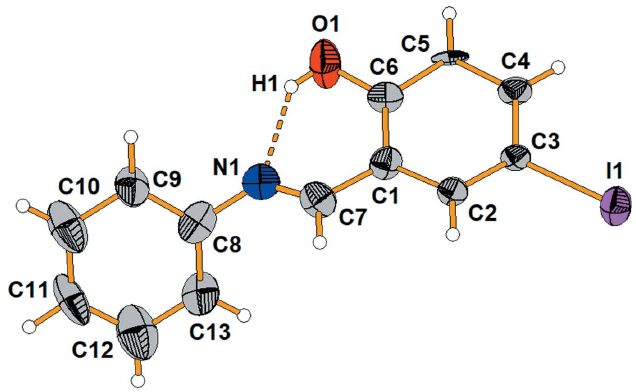
Figure 1 A view of the molecular structure of the title compound with displacement ellipsoids drawn at the 50% probability level and showing the atom-numbering scheme. Dashed lines indicate the intramolecular hydrogen-bonding interaction (Table 1).